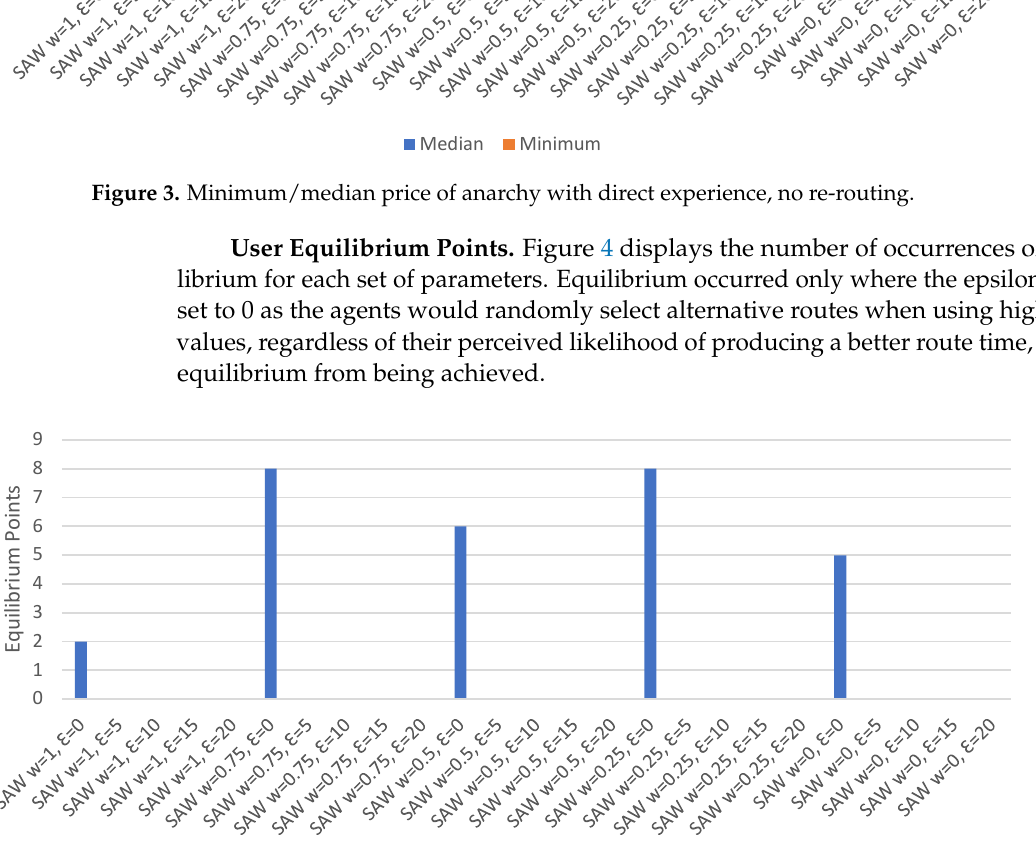
Figure 4. Equilibrium points with direct experience, no